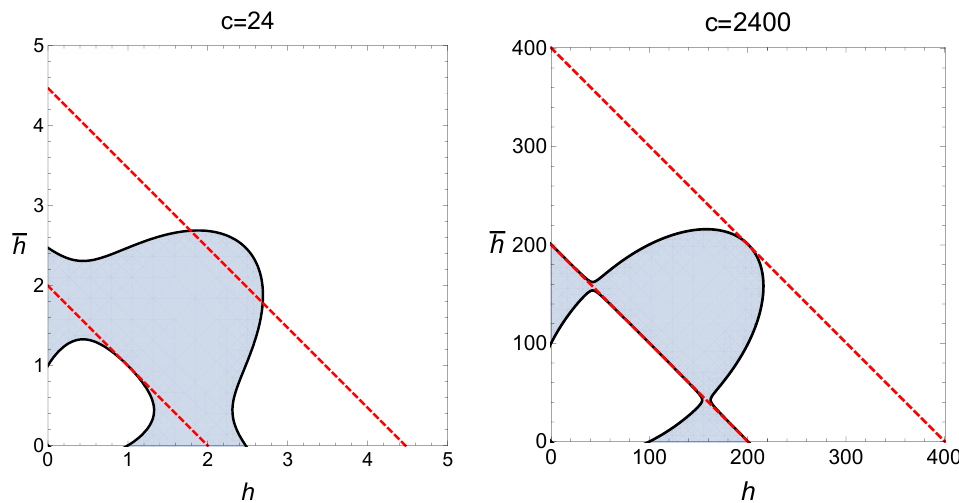
Figure 2: In any CFT, a state should exist within the blue shaded region. The dashed red lines delimit the existence region derived in [ 51 ] whose upper bound asymptotes + 0.473695 as c → ∞ . Along the line h = h = ∆ / 2, the tip of the to h + h = c 6 + 0.951160 at large- c . Interestingly, the h and h shaded region asymptotes to ∆ = c 6 intercepts of the upper boundary of the shaded region are at c / 12 at leading order in c